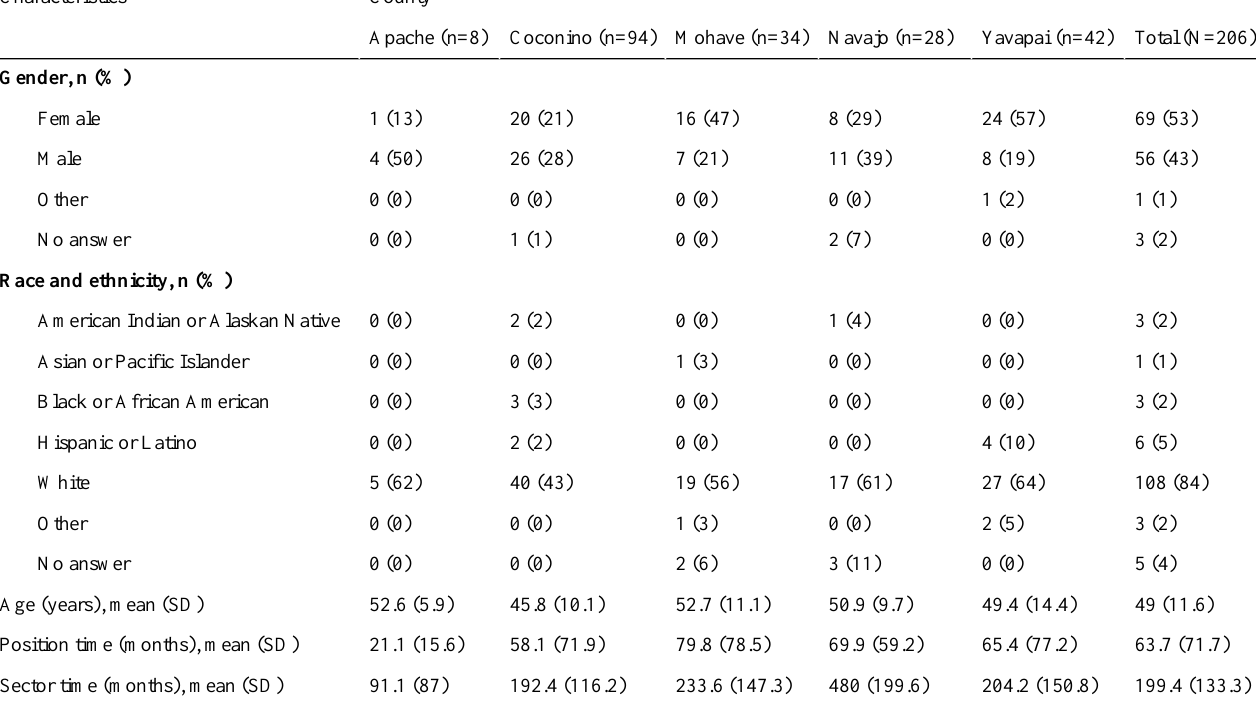
Table 1. Participant demographics by county. CountyCharacteristics